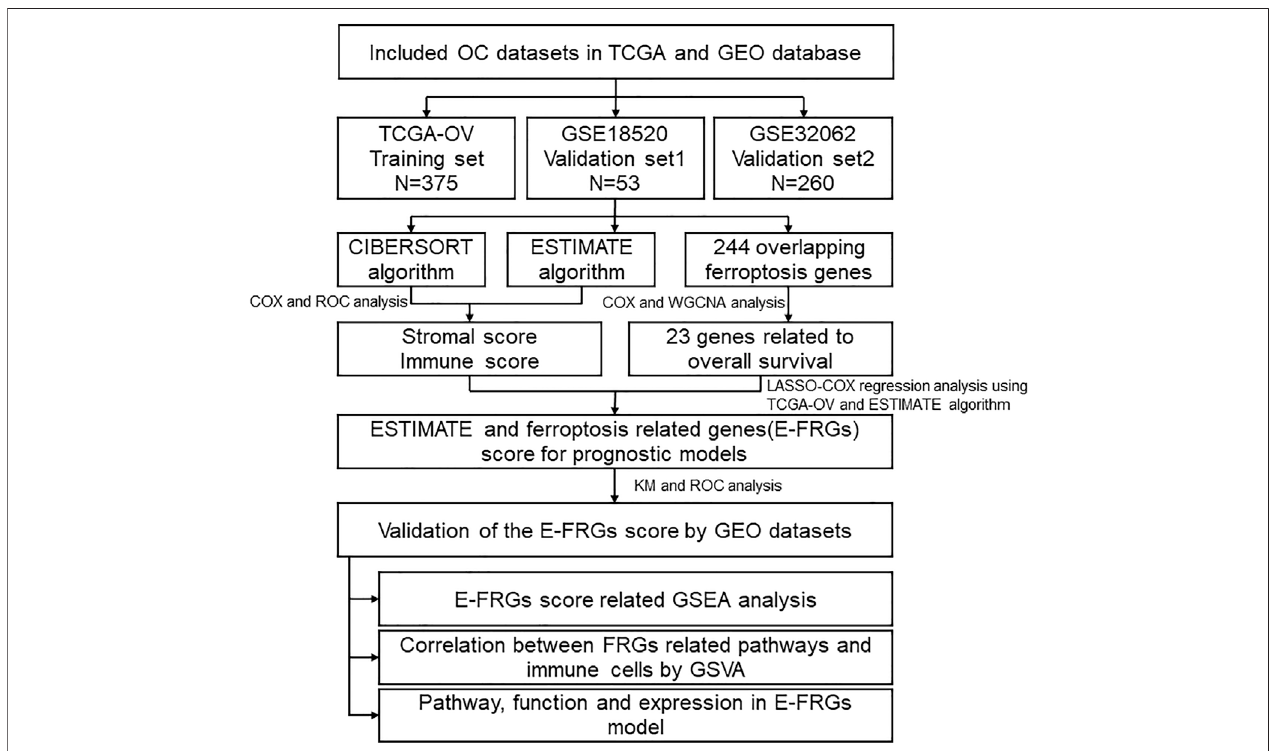
FIGURE 1 | Overall fl owchart. First, use ESTIMATE and CIBERSORT were used to analyze the relationship with the prognosis of OC patients. Furthermore, the ESTIMATE scores and ferroptosis-related gene expression were combined toconstruct the E-FRG model. Finally, the possible regulatorypathway wasanalyzedbased on the E-FRGS